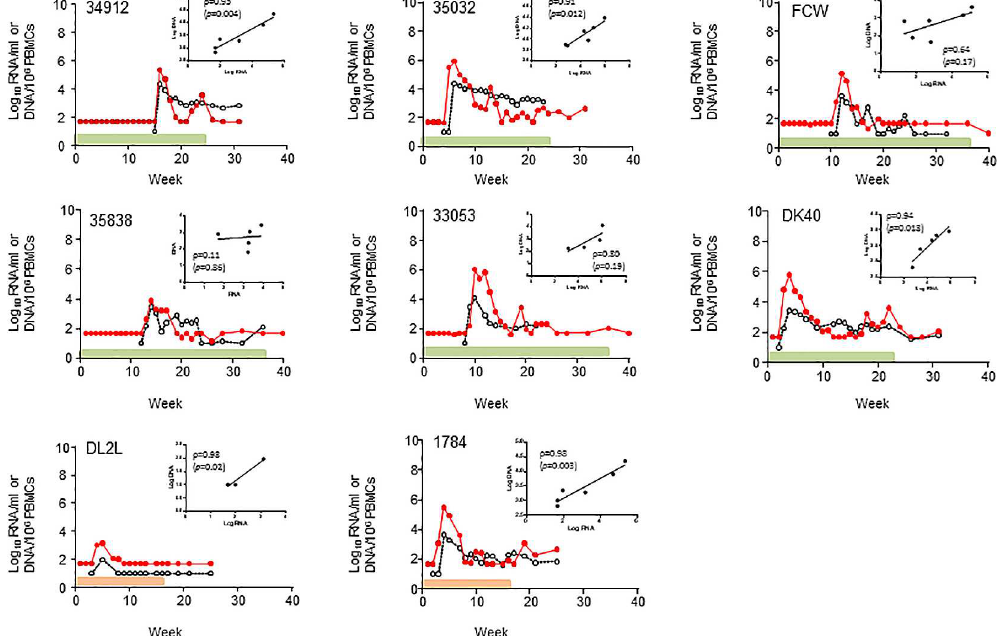
Fig 2. Acute plasma RNA and cell-associated SHIV DNA levels in macaques infected with SHIV 162P3 while receiving PrEP. Time 0 denotes peak plasma viremia. SHIV RNA levels in plasma are shown in red. Cell- associated SHIV DNA levels in PBMCs are shown in black. The shadedareas denote the length of treatment (green = FTC/TDF; orange = TAF). Small panels indicate the correlationbetween plasma RNA and DNA levels seen between peak viremia and week 5. Pearson correlationcoefficients are also shown.